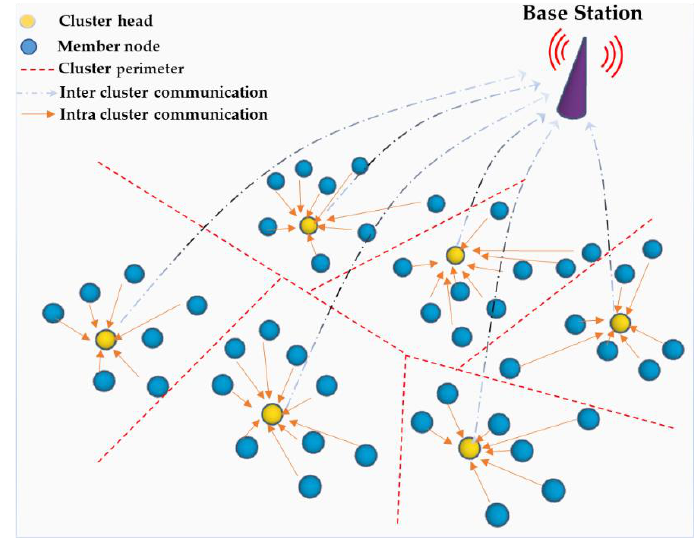
Figure 1. Graphical abstract (3D) of clustering architecture in WSN.